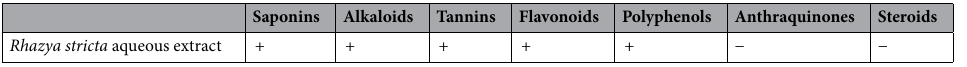
Table 1. Phytochemical analysis of Rhazya stricta , + shows the presence and − shows the absence of molecules.